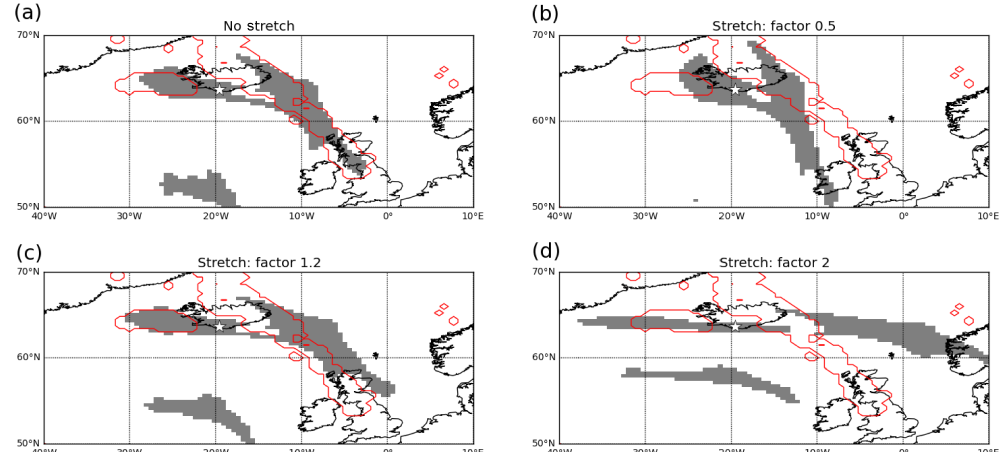
Figure 6. As Fig. 4 for 00:00UTC 9 May 2010.